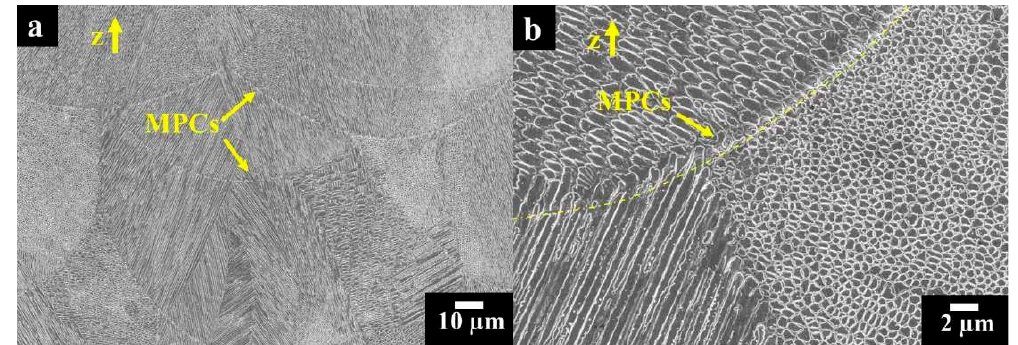
Figure 5. FESEM images at different magnification ( a , b ) exhibiting melt pools with columnar and cellular primary dendrites for as-built IN625 sample; mixed acids reagent.